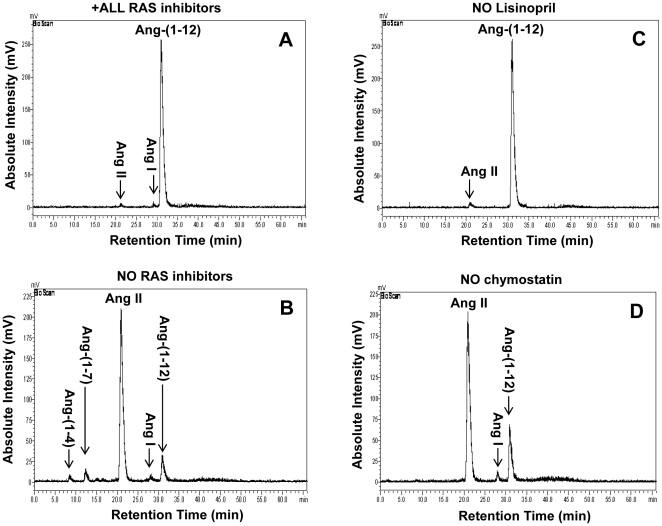
Ang-(1-12) metabolism by human atrial tissue.The metabolism of 125I-Ang-(1-12) by plasma membrane isolated from human atrial tissues was analyzed by HPLC coupled to an inline BioScan γ-detector. The 125I-Ang-(1-12) was incubated with human plasma membrane for 60 min at 37°C with or without the inhibitor cocktail and the metabolites were separated by HPLC. A: Chromatograms represent the hydrolysis of 125I-Ang-(1-12) in the presence of all RAS inhibitors (All RAS inhibitor group containing lisinopril, SCH39370, MLN-4760, chymostatin, bestatin, amastatin, benzyl succinate, and PCMB). B: Hydrolysis of 125I-Ang-(1-12) in the absence of all RAS inhibitors cocktail (No RAS inhibitors group containing only bestatin, amastatin, benzyl succinate, and PCMB). C: Hydrolysis of 125I-Ang-(1-12) in the presence of the inhibitor cocktail that lacks only Lisinopril (No lisinopril inhibitor group containing all inhibitors as described in “A” except ACE inhibitor). D: Hydrolysis of 125I-Ang-(1-12) in the presence of inhibitor cocktail that lacks only chymostatin (No chymostatin group containing all inhibitors as described in “A” except chymase inhibitor). Before adding the 125I-Ang-(1-12), the plasma membrane was pre-incubated with inhibitors (each added at a dose of 50 µM) for 15 min at 37°C. The arrow indicates the retention time of 125I-Ang-(1-12) and its metabolic products. HPLC results are representative of three or more separate metabolism experiments for each human sample.